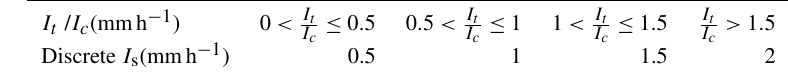
Table 4. The ratio of I t to I c of each period corresponds to the discrete rain intensity I s .